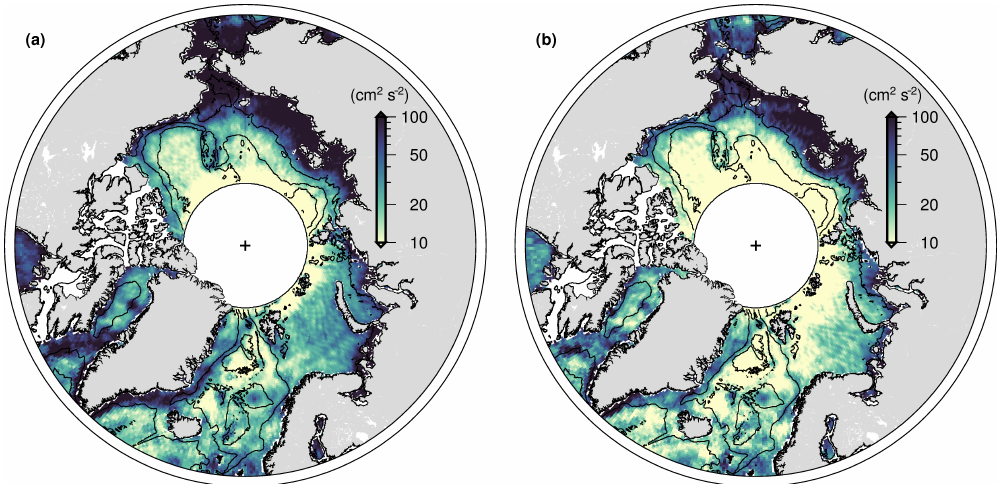
Figure 7. The November–June (a) and July–October (b) eddy kinetic energy. Depth contours are drawn at 50m, 1km and 3km, taken from the ETOPO1 global bathymetry model (Amante and Eakins, 2009). Note that the Canadian Arctic Archipelago has been masked out in these plots (see Sect.